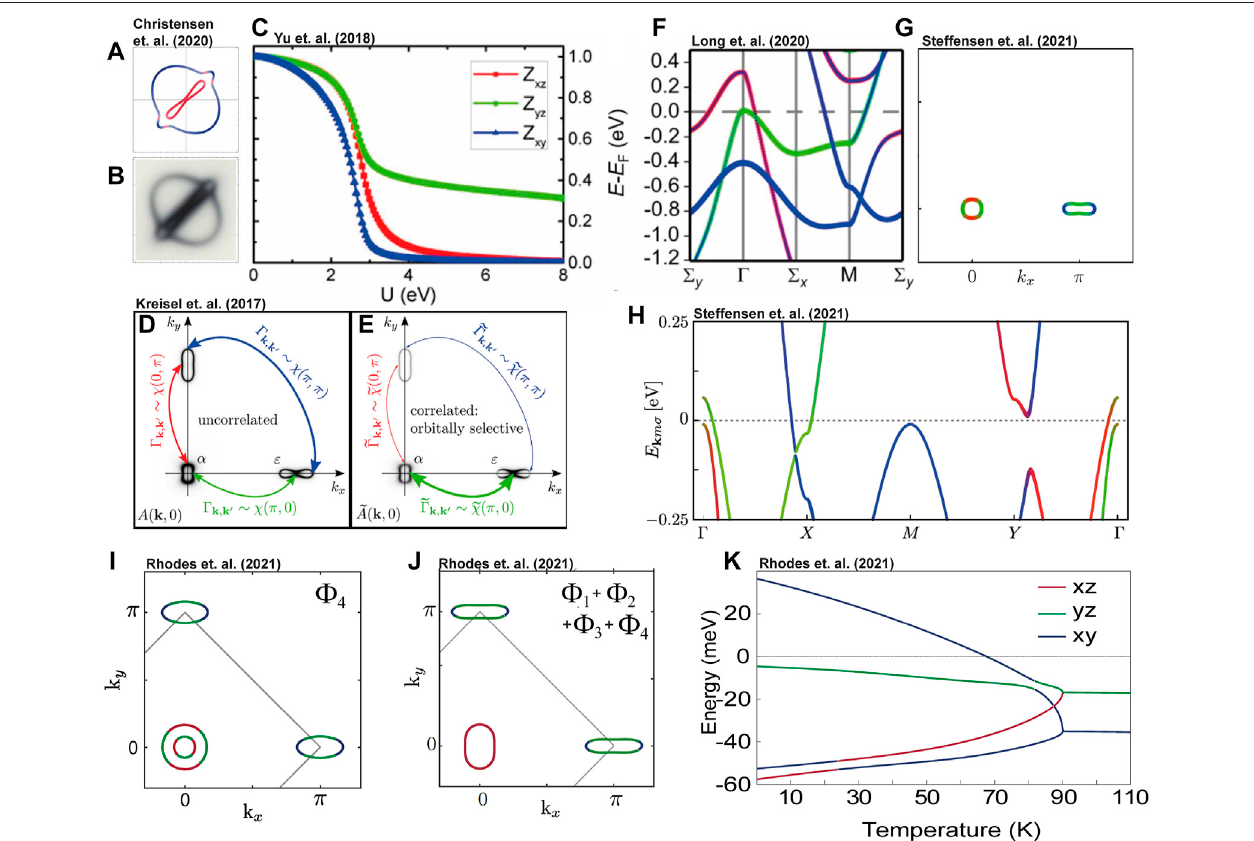
FIGURE 7 | Theoretical attempts to resolve the missing electron pocket problem. (A) Fermi surface of the electron pockets in the nematic state proposed by Christensen et. al. [100]. The spectral function is argued to have an increased decoherence of d xy weight, which is argued would not be observed by experiment and is simulated in (B) . (C) Slave-spin calculations from Yu et. al. [24], revealing the possibility of highly anisotropic quasiparticle weights with local Coulomb repulsion. (D,E) Spectral function of the 1-Fe unit cell tight binding model from Kreisel et. al. [21], with and without orbital-selective quasiparticle weights, highlighting the possible suppression of the second electron pocket via incoherent d xz and d xy spectral weight. (F) Band dispersion of FeSe obtained from a DFT + U calculation with symmetry preconditioned wavefunctionsfrom Long et.al. [106],highlighting theband hybridisationobtainedif anE-typenematic order parameter isconsidered. (G) Fermi surface of the 1-Fe unit cell model from Steffensen et. al. [108] taking into account a self consistently obtained E-type nematic order parameter. (H) Band dispersion from the model used by Steffensen et. al. [108] showing a band hybridisation of the d xz (red) and d xy (blue) bands around the Y point (1-Fe unit cell), gapping out the second electron pocket. (I) Fermi surface obtained from the 2-Fe unit cell tetragonal model from Figure 6A assuming dominant d xy nematic ordering, as suggested by Rhodes et. al. [67]. (J) Equivalent Fermi surface including all four symmetry allowed nematic order parameters of FeSe and a symmetry allowed Hartree shift. (K) Mean- fi eld temperatureevolutionoftheelectronicstatesatthehighsymmetryMpoint,highlightingaLifshitztransitionofthe d xy bandandremovalofthesecondelectron pocketas proposed by Rhodes. et. al. [67]. (A,B) Reproduced from Ref. [100] under the Creative Commons Attribution 4.0 International License. (C) Reproduced from Ref. [24] with permission from the American Physical Society. (D,E) Reproduced from Ref. [21] with permission from the American Physical Society. (F) Reproduced from Ref. [106] under the Creative Commons Attribution 4.0 International License.